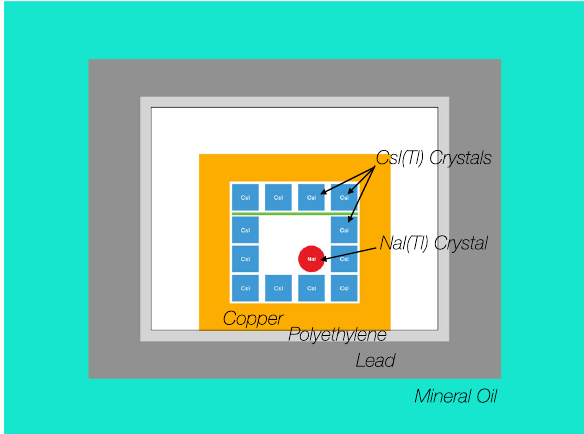
Fig. 6 A schematic view of the Y2L R&D setup. The NaI(Tl) crystal (circle)isplacedwithintheCsI(Tl)crystalarray(squares)totagexternal andcoincidentcomponentsofthetestingcrystal.Anacrylictable(green solidline)supportstop-sideCsI(Tl)crystals.Thesewereinstalledinside a shield. Each NaI(Tl) crystal was tested one by one in this